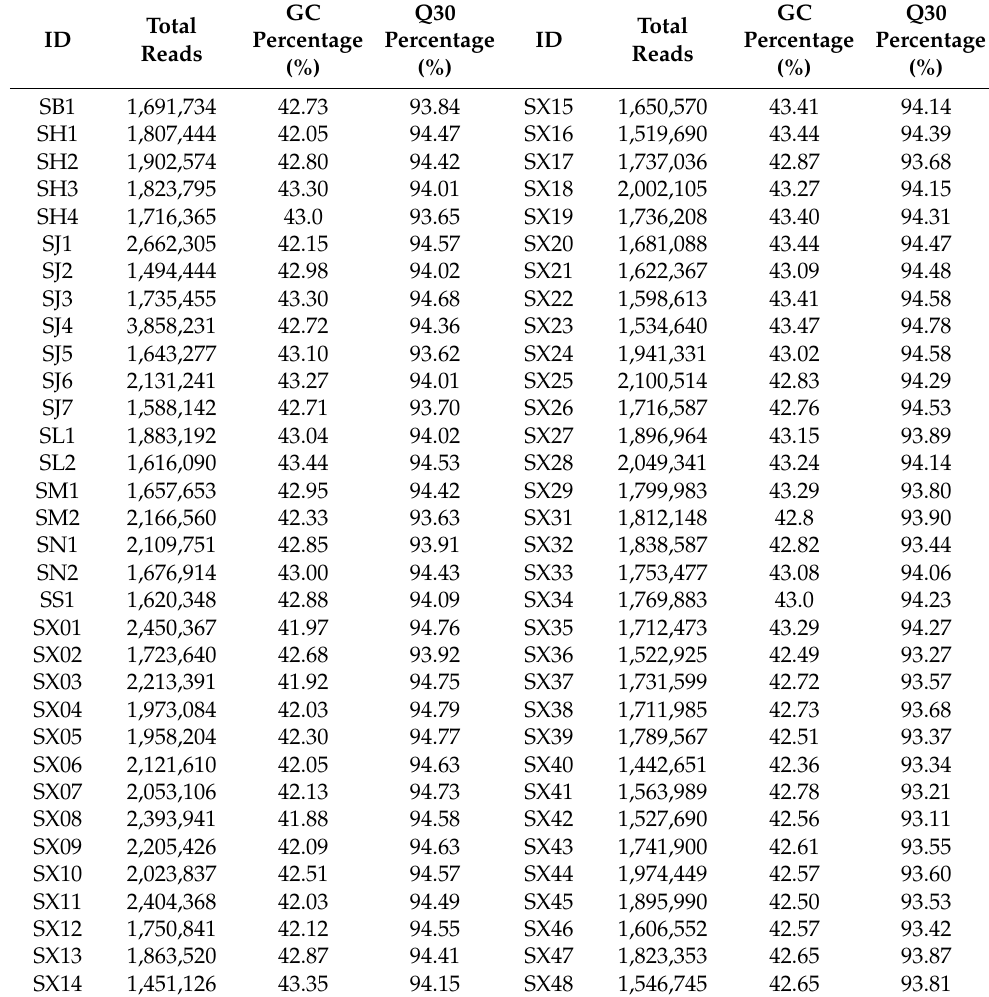
Table 2. Summary statistics for specific-locus amplified fragment sequence data of S. nigrum